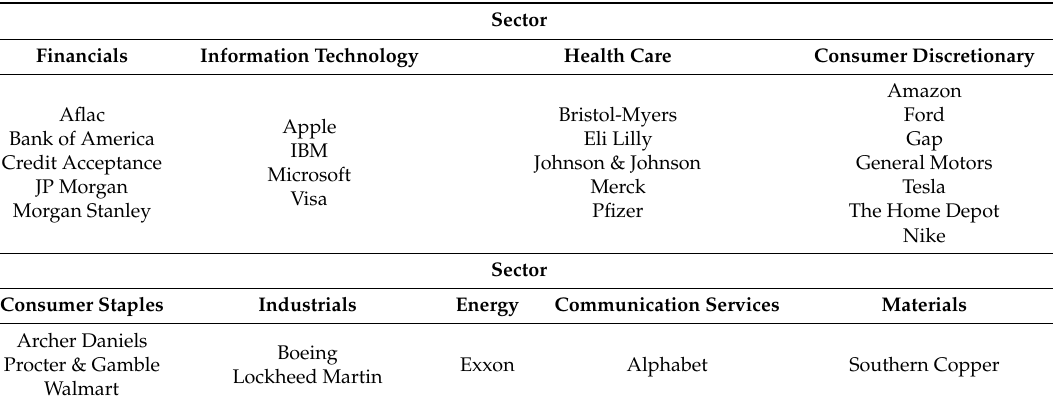
Table 1. Companies analyzed in the